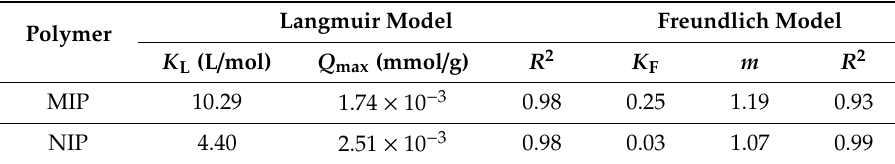
Table 4. K L , Q max and R 2 , and K F , m , and R 2 values obtained by Langmuir and Freundlich models,